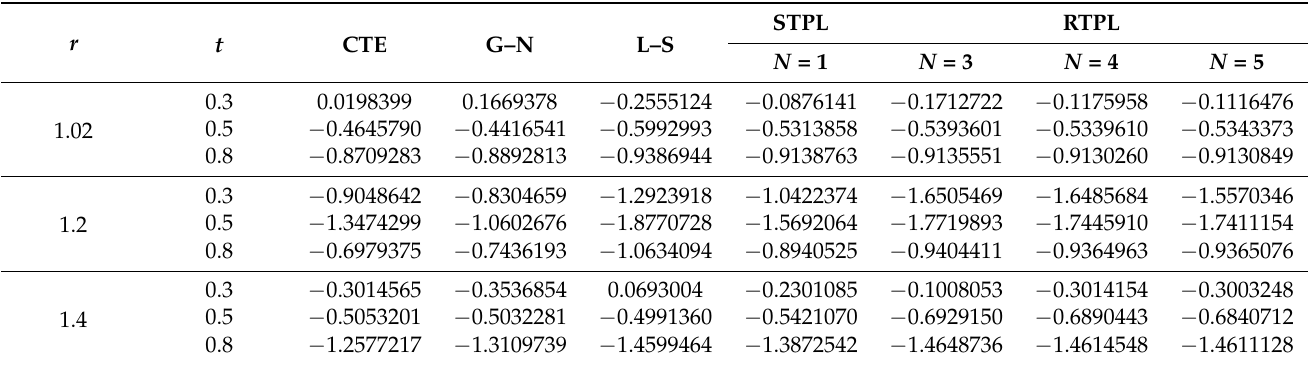
Table 5. Different thermoelasticity theories with a range of r values show the effects of dimensionless time t on circumferential stress σ ΘΘ .